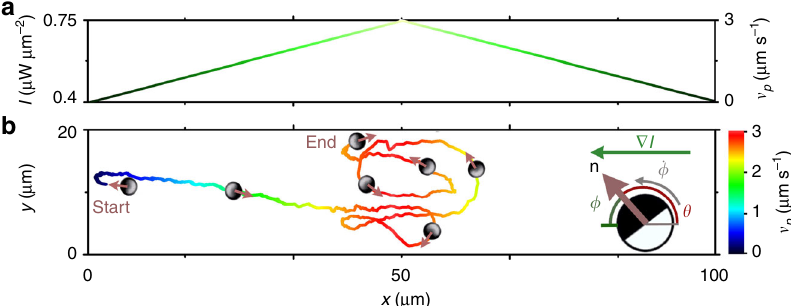
Fig. 1 Positive phototaxis. a One-dimensional triangular light intensity pro fi le (left axis) and corresponding propulsion velocity v p (right axis). b Measured trajectory of a positive phototacting AP in the light gradient with its propulsion velocity v p labeled in color. (Inset) Sketch of an AP in a light gradient ∇ I . The fl uid ’ s fl ow fi eld around the particle becomes axially asymmetric relative to the particle ’ s orientation n , which results in a torque which aligns the AP parallel to ∇ I 37 . ϕ is the angle between ∇ I and the particle orientational vector n . The angle θ describes the particle orientation n relative to the positive